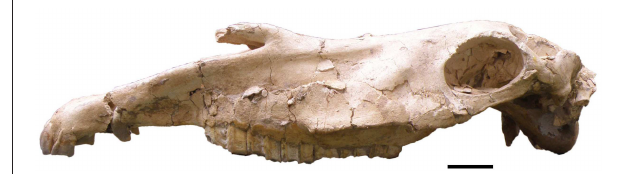
FIGURE 5 | Left lateral view of skull of E. huanghoensis , NWUV 1403.1, collected from Yangshuizhan Locality, Nihewan Basin. Scale bar = 5cm.